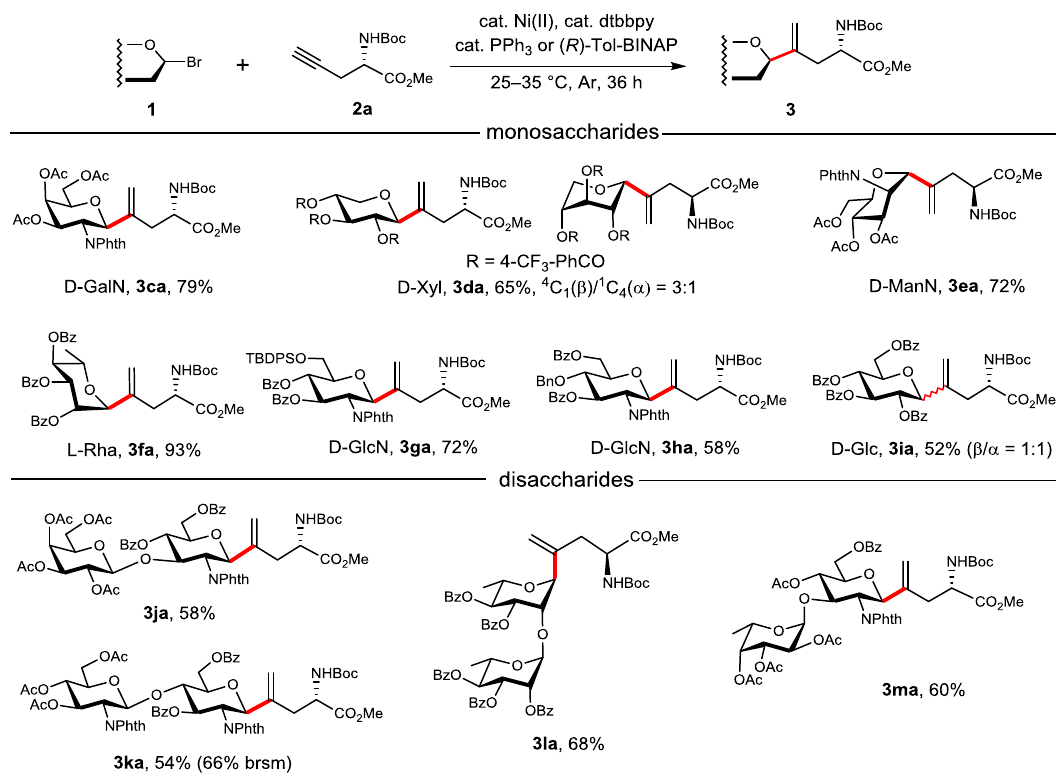
Fig. 5 C -Glycosylation with various mono- and disaccharide bromides. See SI for detailed conditions, which might vary slightly from Conditions I and II, and isolated yields are reported. In red are the formed C -glycosidic bonds.